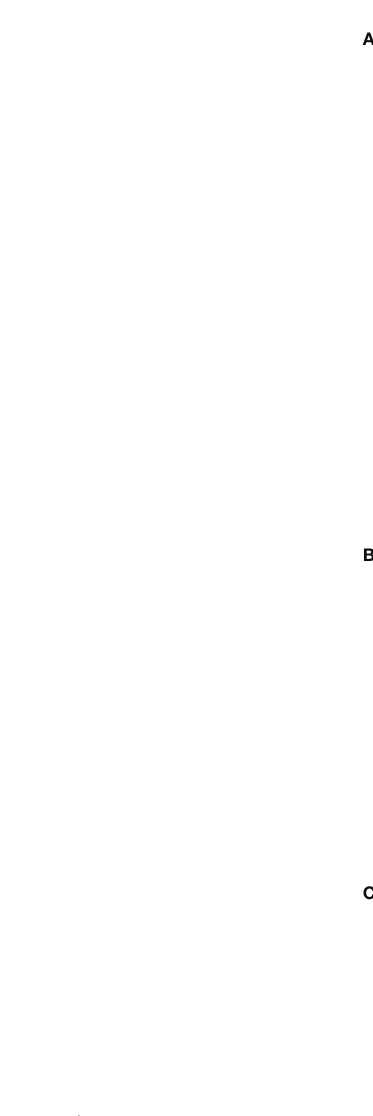
FIGURE 8 | Mitochondrial expression of YFP-Sx(1-6) transmembrane peptides. HEK 293 cells were transfected with several YFP-Sx(1-6) transmembrane peptides, and mitochondrial expression was studied. (A) Representative immunoblots showing puri fi ed mitochondrial fractions from total lysates (starting materials) and mitochondrial extracts (mitochondrial fractions). Samples were immunoblotted with antibodies against YFP (YFP-Sx(1-6)), Na + /K + ATPase (membrane marker) and VDAC (mitochondrial marker). (B) Relative mitochondrial YFP-Sx expression is presented in arbitrary units (A.U.). Data are presented as the means ± SE (n=3-5). Blue line, nonlinear regression curve representing a monoexponential decay with all constructs. Red line, nonlinear regression curve representing a monoexponential decay without S5. Note that with slight variations, both lines represent a bona fi de fi tting of data. (C) Calculations of both fi ts. Model 1 (blue) includes values from all YFP-Sx and Model 2 (red) lacks